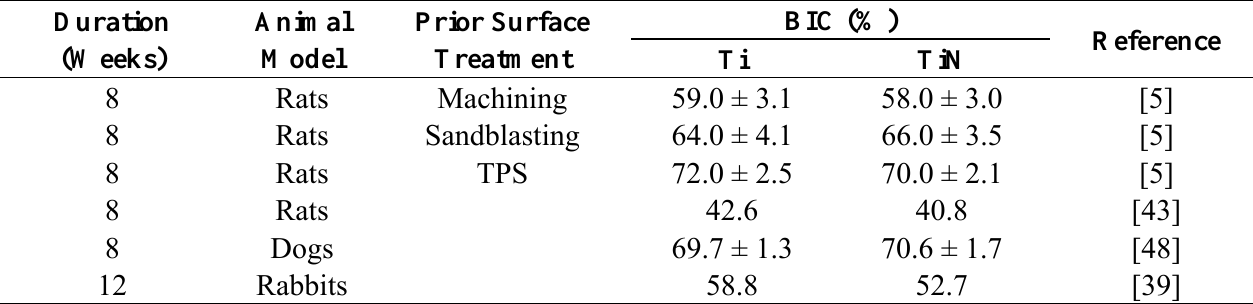
Table 2. Duration of implantation, animal model, and Bone Implant Contact (BIC) for several in vivo implant material